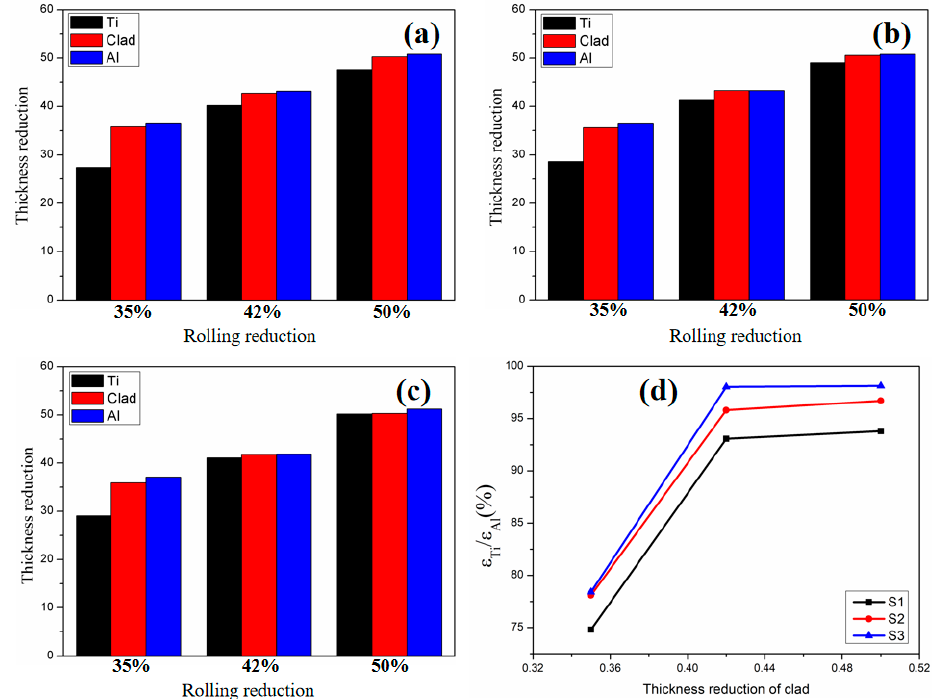
Figure 12. Deformation of each layer of three types of Ti/Al composite sheets under different rolling reductions. ( a ) S1, ( b ) S2, ( c ) S3, ( d ) variation of deformation ratio of titanium and aluminum with total rolling reduction.